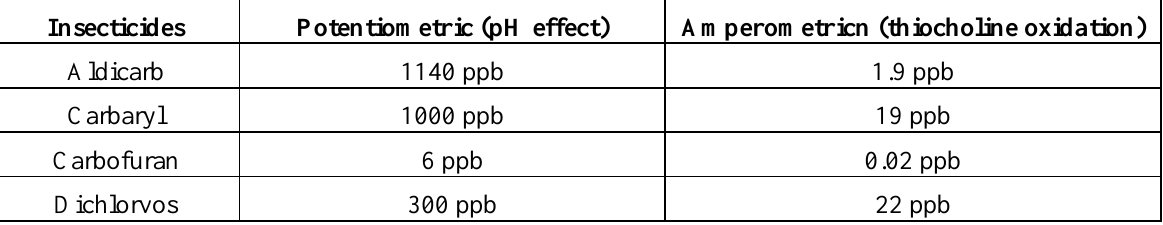
Table 1. Detection limits for insecticides (carbamates and organophosphorus compounds) obtained with potentiometric and amperometric transducers.